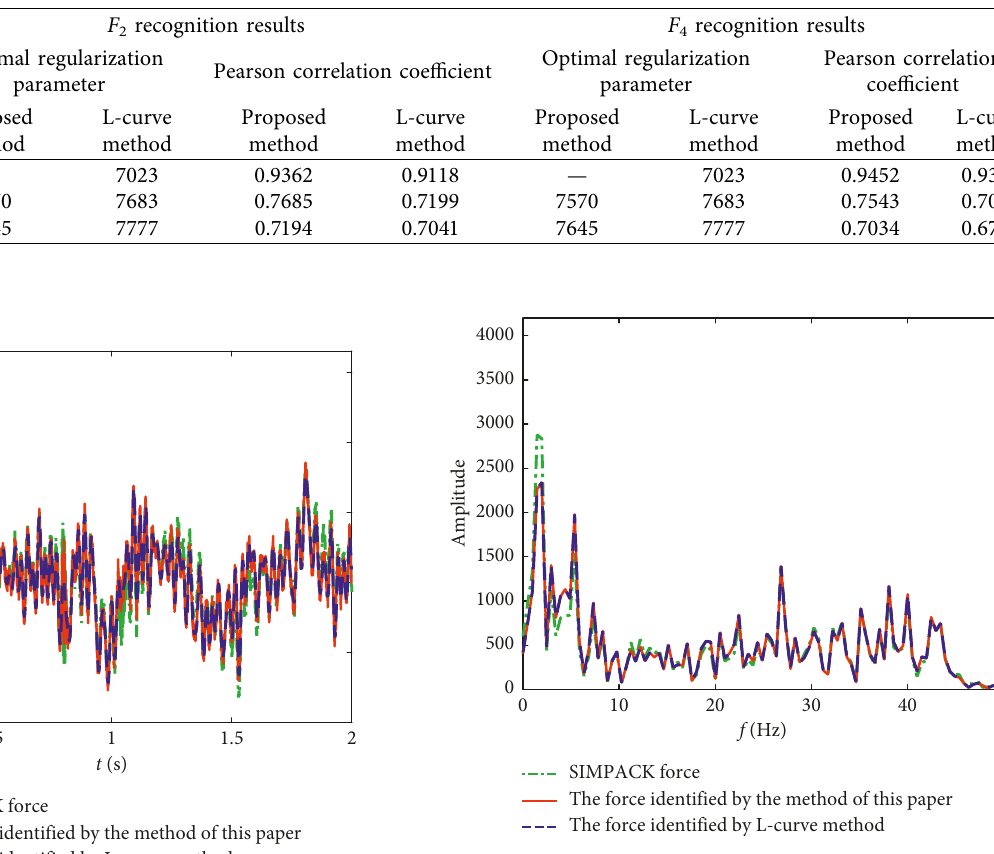
Table 4: Comparison of the calculation results for F 2 and F 4 obtained using the L-curve method and the proposed method.